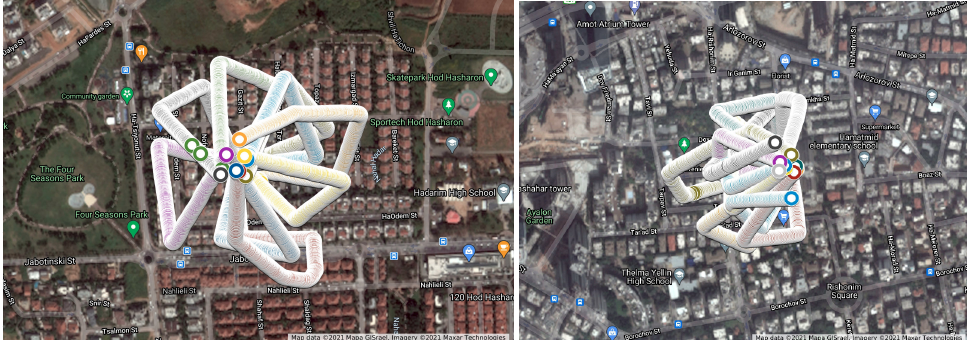
Figure 11. The drone flight route for location #1 (the left image) and location #2 (the right image) from an altitude of 100